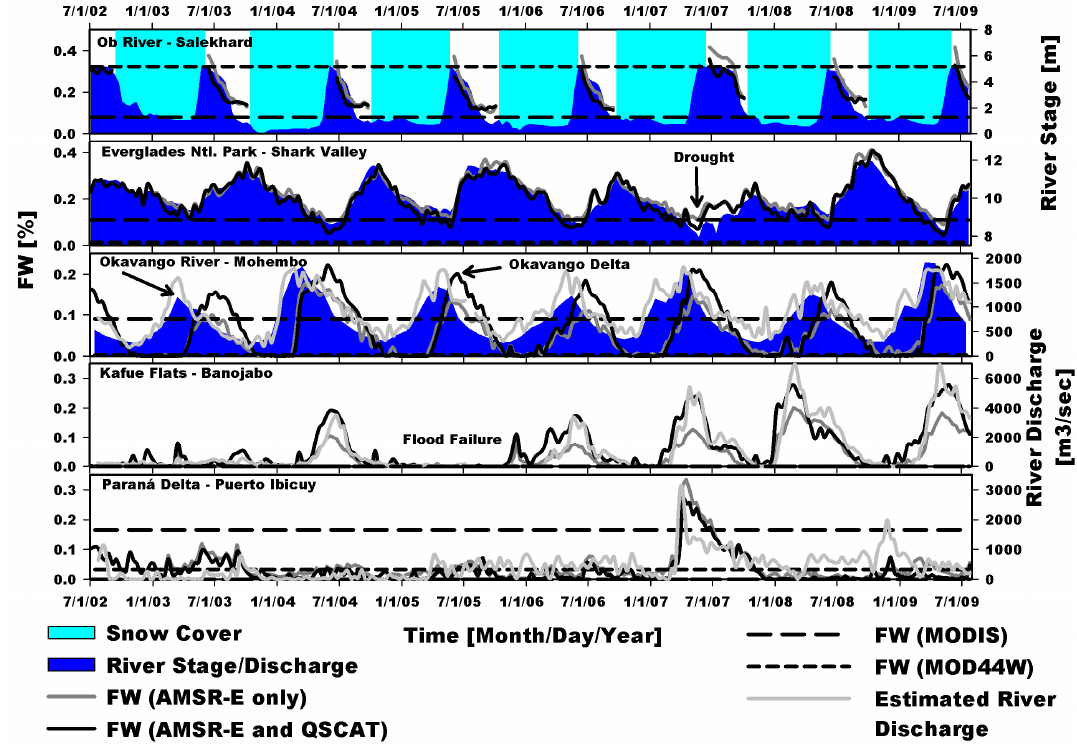
Figure 13. 10-Day intervals of in-situ river discharge/stage, satellite estimated river corresponding fractional water (FW) from combined AMSR-E and QSCAT and AMSR-E only [58] for discharge and corresponding fractional water (FW) from combined AMSR-E and QSCAT five selected wetland sites over an 8 year period (7/2002–7/2009). Static FW from MOD44W and and AMSR-E only [58] for five selected wetland sites over an 8 year period (7/2002–7/2009). MODIS including wetlands is shown for Static FW from MOD44W and MODIS including wetlands is shown for reference.